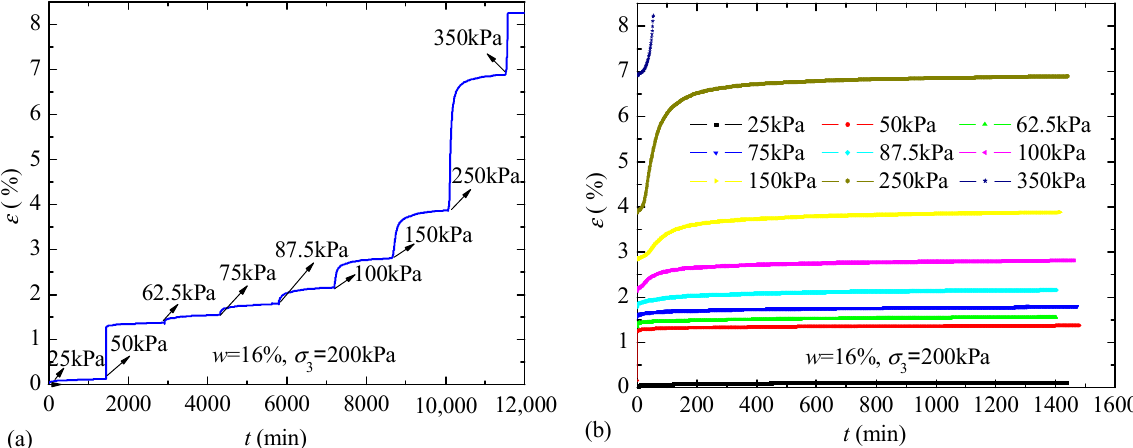
Figure 5. ( a ) The whole process curve of creep for loess without dry-wet cycles, ( b ) creep curves of the loess without dry-wet cycles.